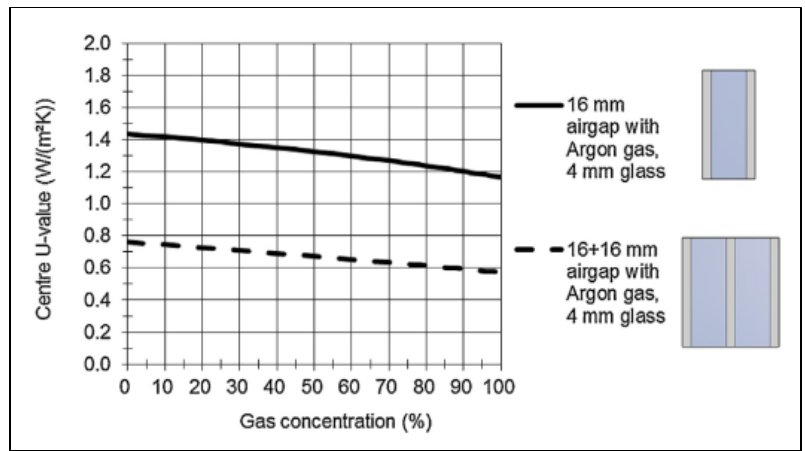
Figure 10. Increasing Center U-value with Decreasing Gas Concentration [5].